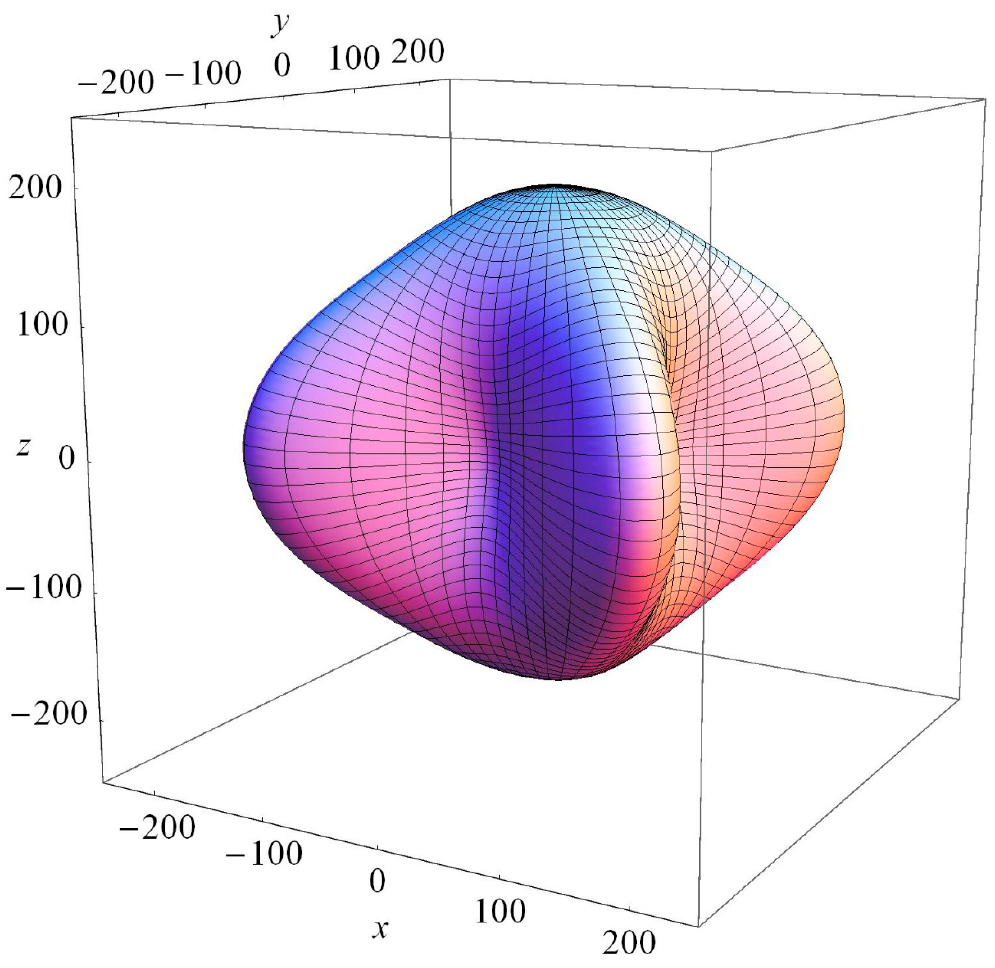
Figure 7. Directional dependence of Young’s modulus (in GPa) of MgBi 2 O 6 .